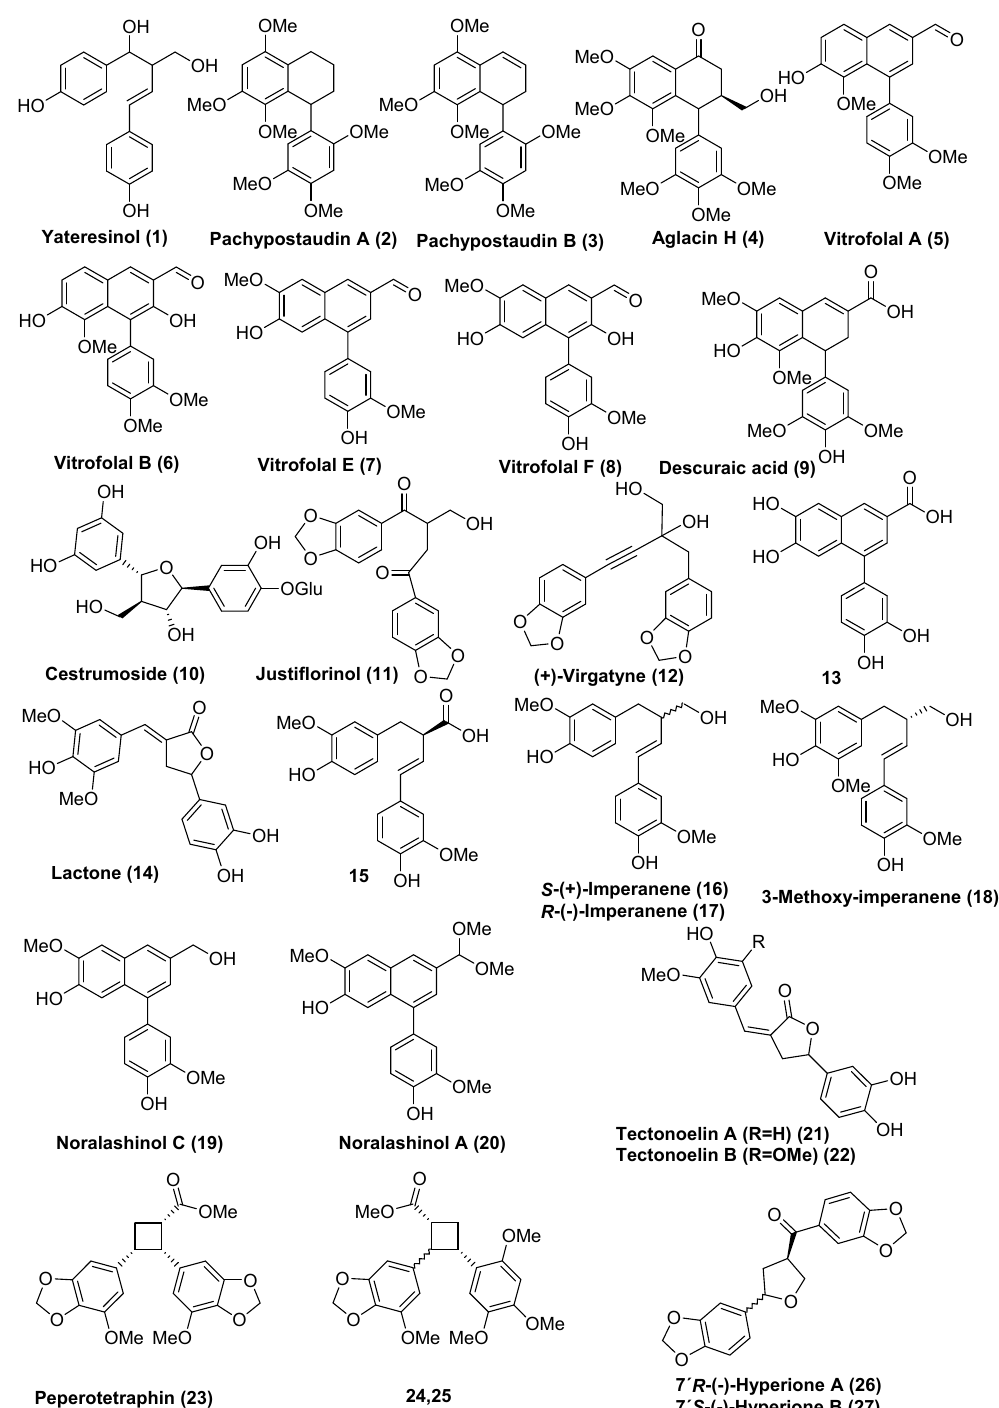
Figure 2. The structures of previously reported 9-norlignans with natural origin.